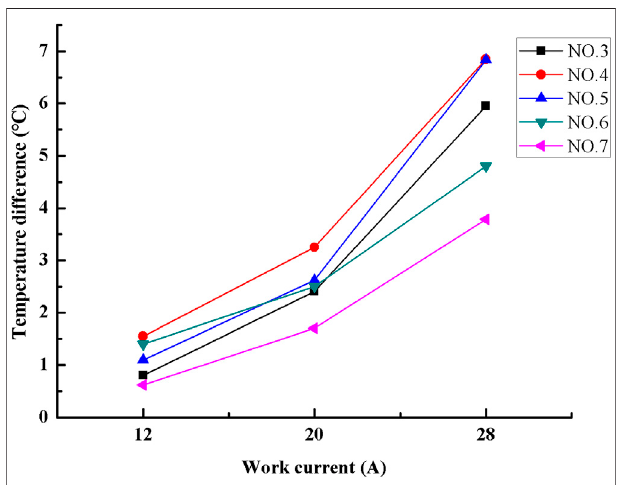
FIGURE 6 | Temperature differences at the measuring points under different working currents.